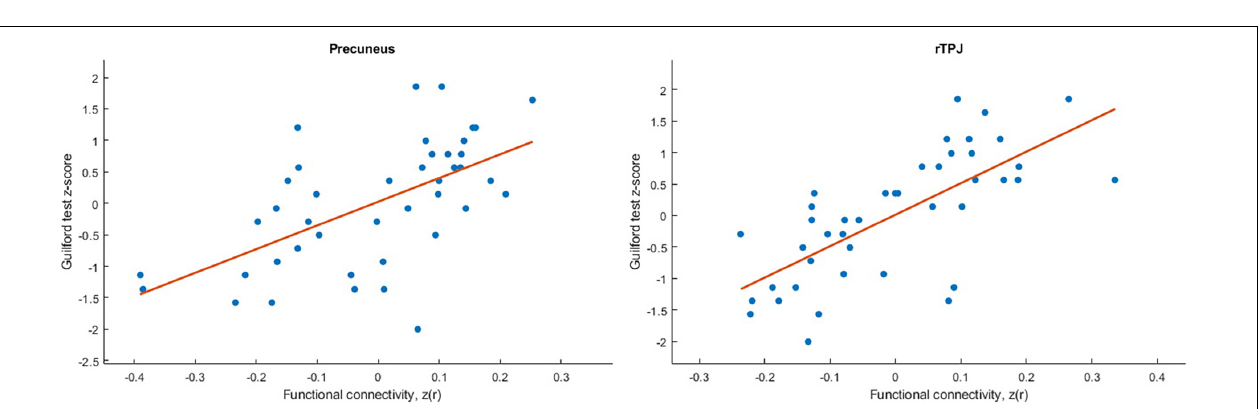
FIGURE 4 | Scatterplots illustrated the association of functional connectivity between the right caudate head and both clusters in precuneus and rTPJ and Guilford test